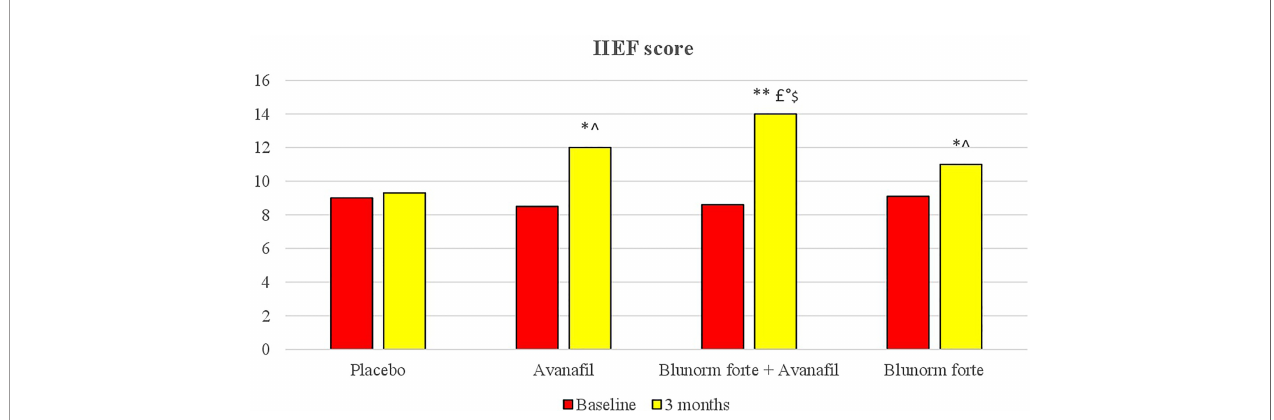
FIGURE 2 | IIEF (International Index of Erectile Function) questionnaire at baseline and after treatments. *p < 0.05 vs baseline; **p < 0.01 vs baseline; ^p < 0.05 vs placebo group; £ P < 0.01 vs placebo group; °p < 0.05 vs Avana fi l group; $p < 0.05 vs Blunorm forte goup. Score from 22 to 25: normal sexual activity. Score from 17 to 21 mild erectile dysfunction. Score from 12 to 16 mild-moderate erectile dysfunction. Score from 8 to 11 moderate erectile dysfunction. Score from 5 to 7 severe erectile